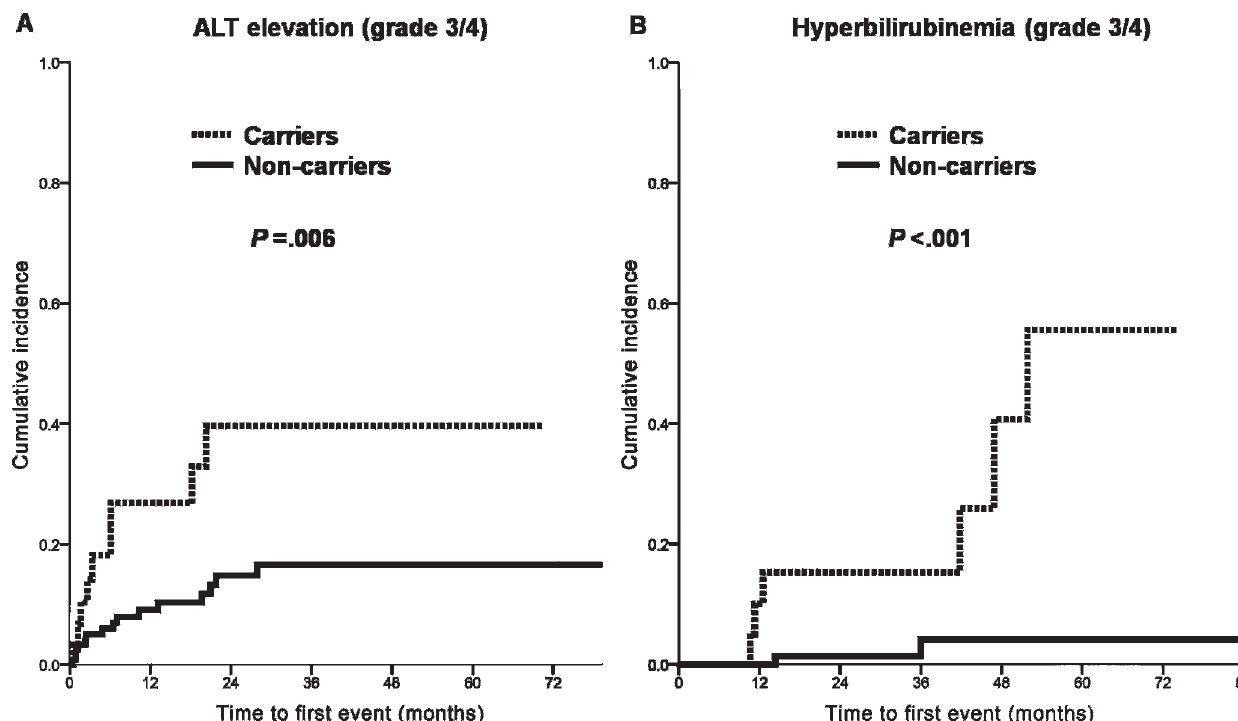
Table 4 - Univariate and multivariate analyses for overall survival in patients with multiple myeloma. Univariate Multivariate* HR 95% CI p- value p- value Viral hepatitis (carriers vs. non-carriers)